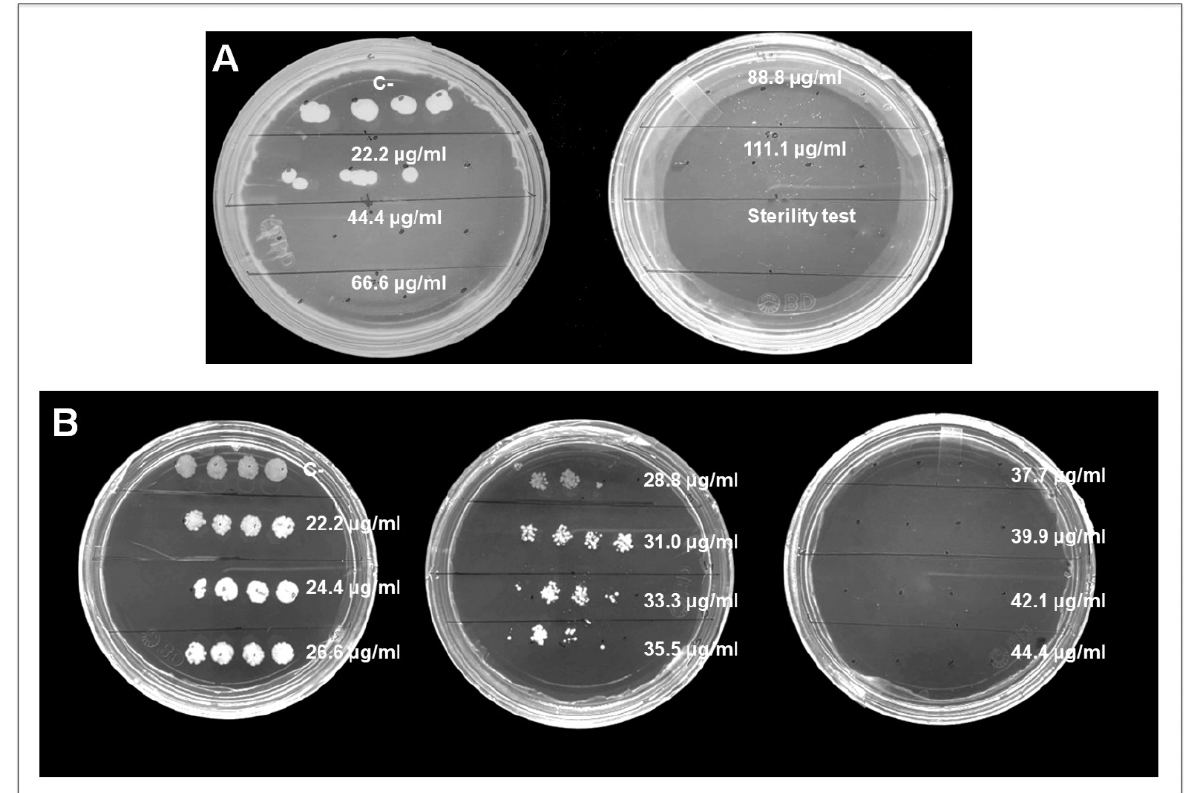
Figure 5. ( A ) Growth of C. albicans after 48 h treatment with CuONPs at different concentrations; ( B ) Colony growth after 48 h of incubation with CuONPs for MIC determination after broth microdi- lution assay. C- = negative